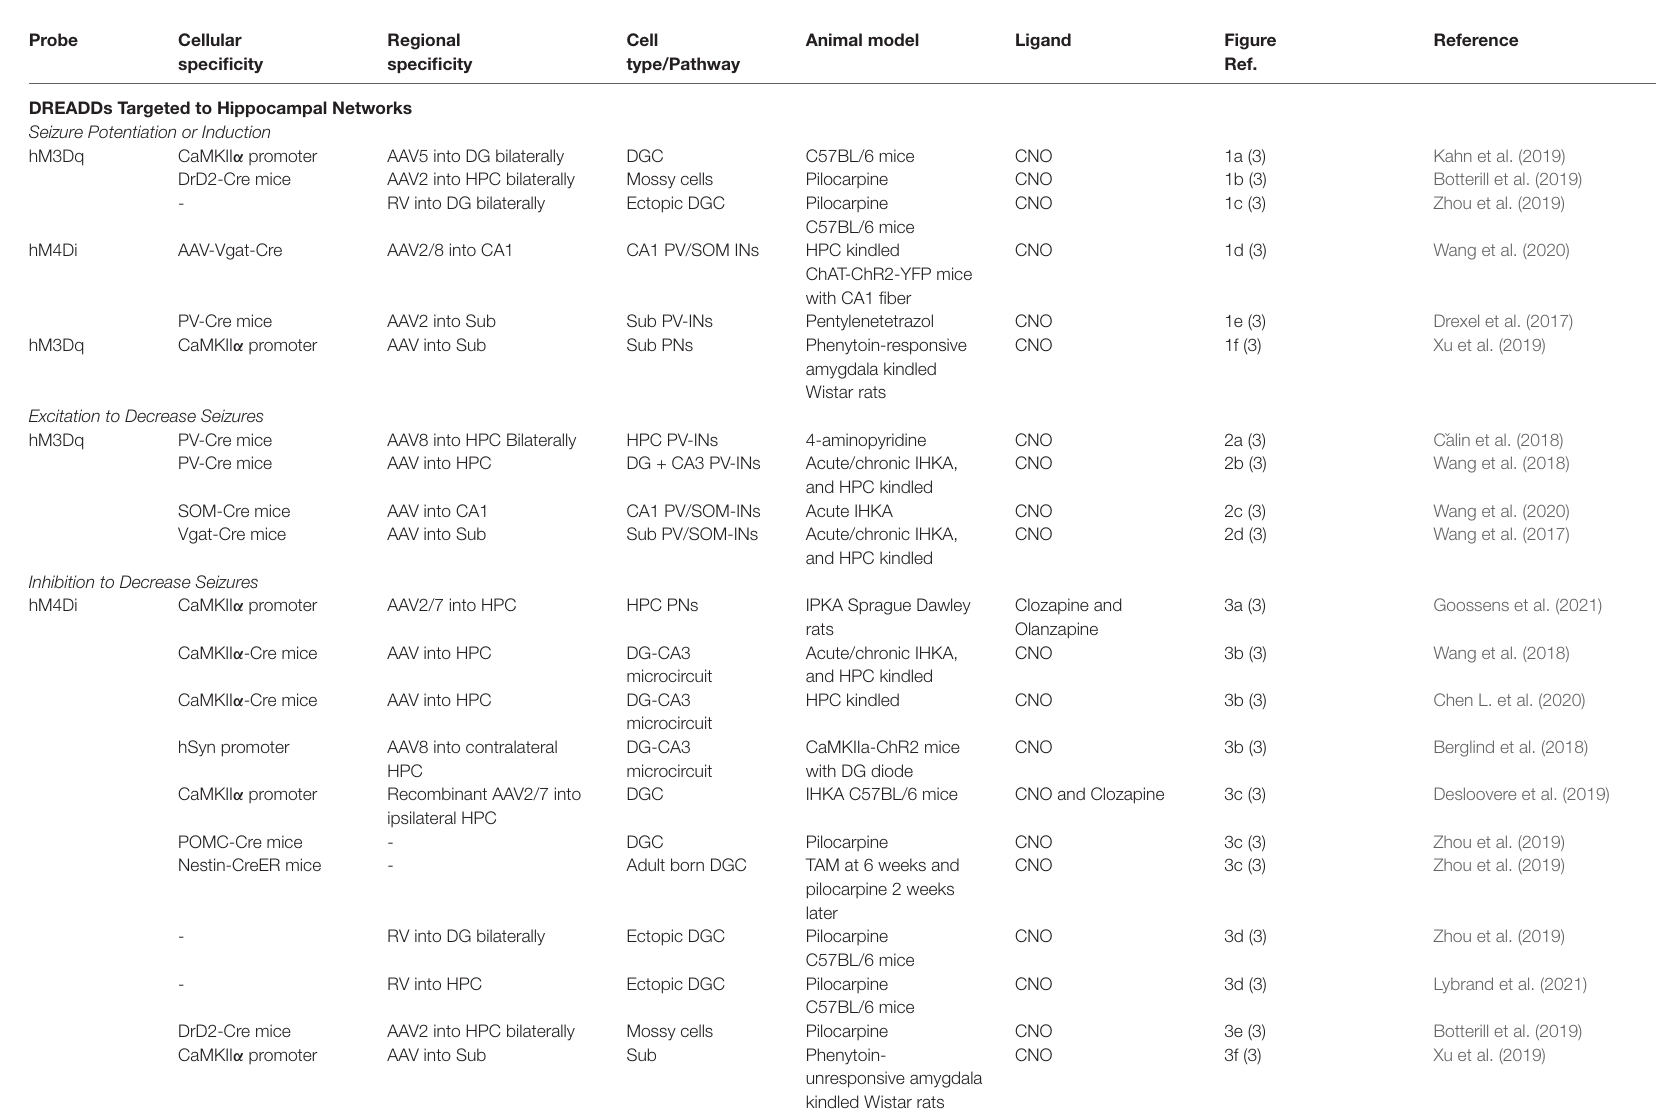
TABLE 1 | Responses of DREADDs targeted to hippocampal and extrahippocampal networks.